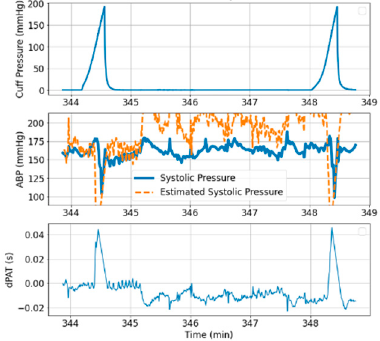
Figure 16. Example of time segment not included in the analysis.